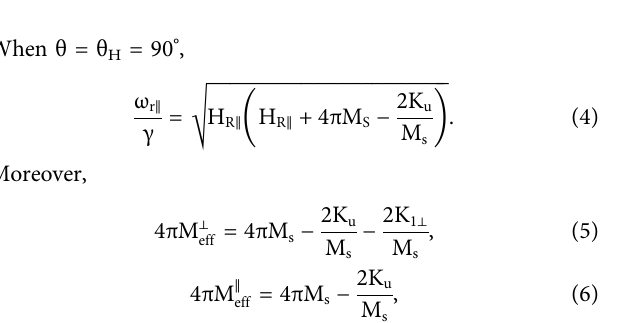
FIGURE6| Resonance magnetic fi eld dependence onthefrequencyin (A) 10-and (B) 30-nm-thick fi lms. Anextraspin-wavemode (SWR)wasdetected in thein- plane ferromagnetic resonance spectra.